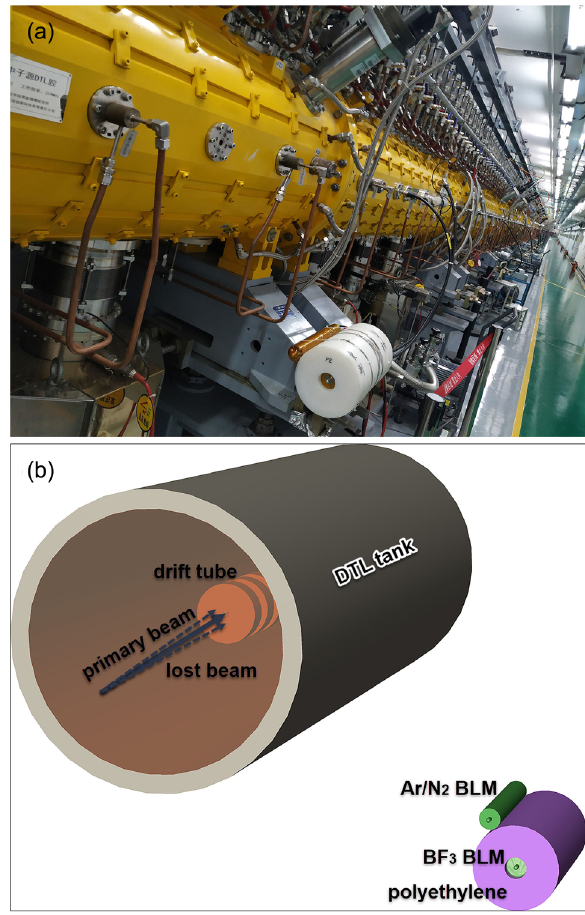
FIG. 25. (a) Experimental layout of two types of BLM installed at the first tank of DTL, and (b) the geometric model imple- mented in FLUKA .